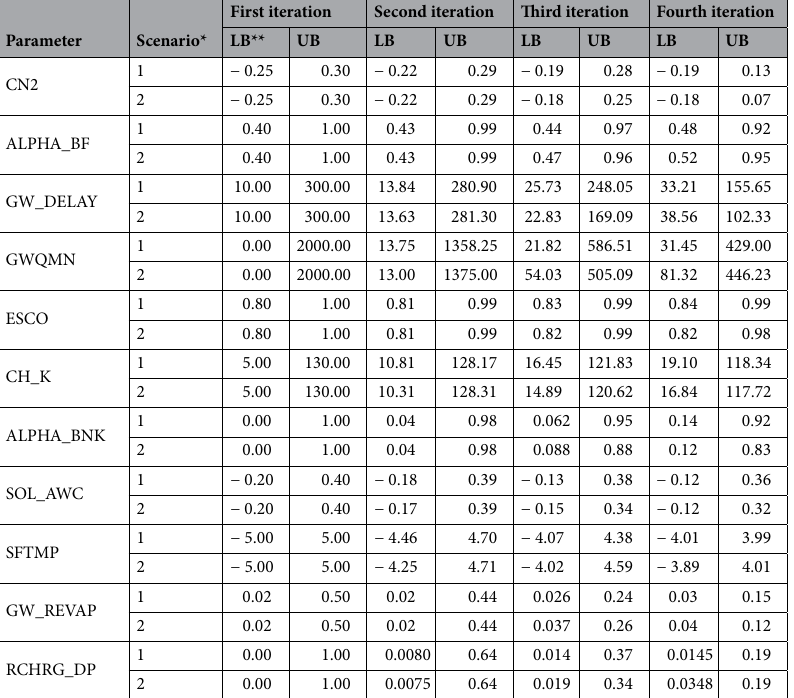
function for four iterations were set as the same for the one criterion case (0.2, 0.4, 0.6, and 0.6). The R 2 was used as the additional criterion in each iteration. Due to the good correlation between simulated runoff results and observed surface runoff, the values were set as 0.60, 0.70, 0.75, and 0.75 for the four iterations. For the first iteration, the threshold value of the objective function was set to 0.20. Two situations were ana- lyzed separately, including the results for behavioural parameters and the refined behavioural parameter sets in each iteration. The threshold value of the second criterion R 2 was set to 0.60 for screening the refined behavioural parameters among the behavioural parameter sets. There are 81 refined behavioural parameter sets among 86 behavioural parameter sets in this iteration. Because only five parameter sets were removed from behavioural parameter sets due to the lower R 2 values, P-factor and R-factor are the same for the two situations, which are 0.50 and 0.90, respectively. The values of R 2 and NSE of the best-calibrated simulation are 0.79 and 0.68, indi- cating reasonably good simulation results. Because the best-calibrated simulation was not removed when using additional criteria, the R 2 and NSE of the best simulation will not change for two situations within an iteration. According to the 95PPU of the 81 parameter sets (screened by using two criteria), the updated parameter ranges for the second iteration were calculated. For the second iteration, the threshold value of the objective function increased to 0.40. The 62 behavioural parameter sets can be found. The R 2 and NSE values of the best-calibrated simulation increased to 0.78 and 0.70, respectively. When the R 2 was set to 0.70 for the second iteration, only 34 behavioural parameter sets were left as refined behavioural parameter sets. Therefore, the P-factor and R-factor were different for the two situations. The R-factor of two criteria (0.66) was smaller than that of one criterion (0.71), showing reducing the prediction uncertainty. The same P-factor value of 0.47 indicated that the reducing uncertainty did not affect the model prediction power and still covered the same number of observed data. The results with reduced uncertainty through two criteria were preferred results, and the 95PPU of the 34 refined behavioural parameter sets were used to calculate the parameter ranges for the third iteration. For the third iteration, the threshold value of NSE was set to 0.60. There are 74 behavioural parameter sets after screening. The R 2 and NSE values of the best-calibrated simulation were 0.78 and 0.73, respectively. The R 2 and NSE values were greater than the results in the second iteration, indicating the improvement of the calibrated results. The additional criterion R 2 was increased to 0.75 in this iteration for getting better refined behavioural parameter sets. Within 74 behavioural parameter sets, 41 parameter sets can achieve the value of R 2 greater than 0.75. The R-factor reduced from 0.52 to 0.45 when using two criteria. Even though the P-factor reduced a little (from 0.44 to 0.42), the P-factor ratio and R-factor ratio increased from 0.85 to 0.93, showing the improvement of uncertainty analysis results. The 95PPU values of the 41 refined behavioural parameter sets were used to calculate the parameter ranges for the fourth iteration. The exact values of each parameter range for four iterations were shown in Table 4.